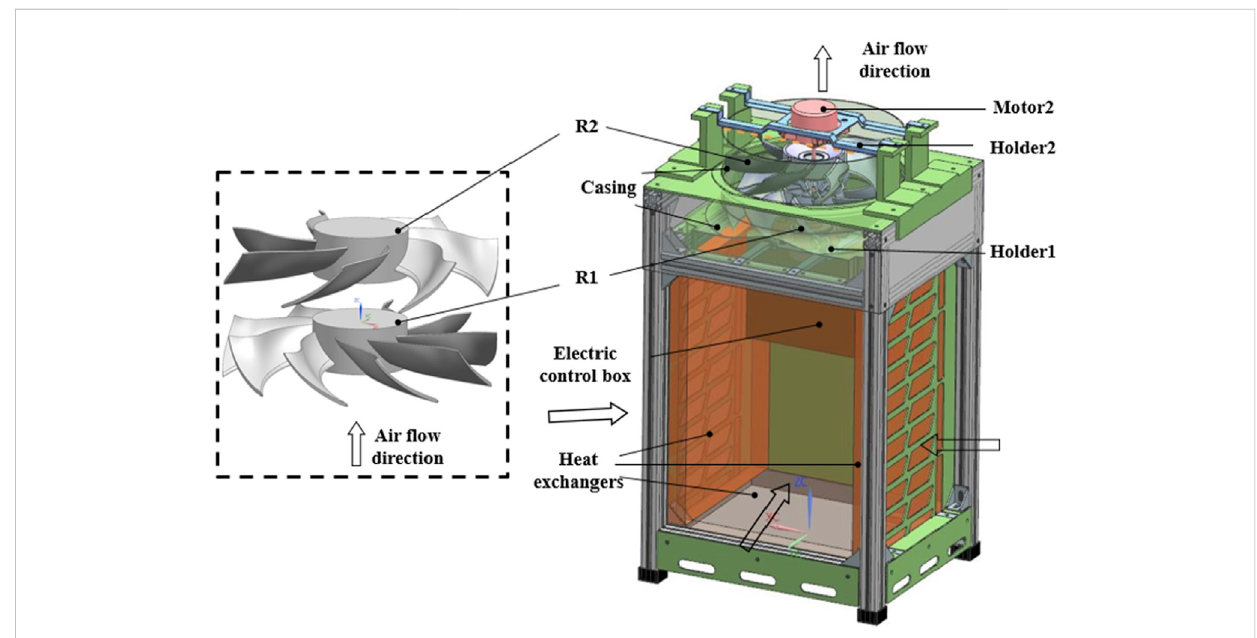
FIGURE 1 Model of the studied contra-rotating axial fan in the